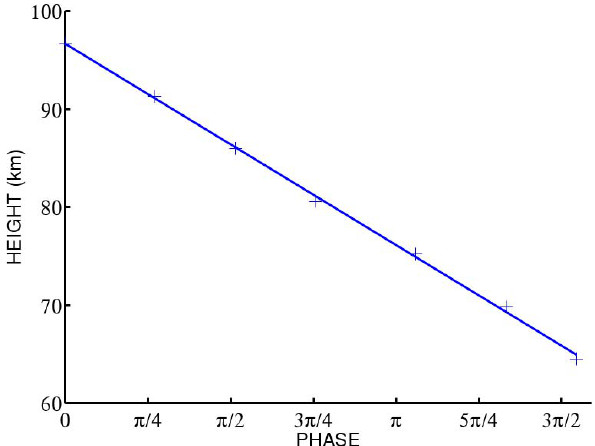
Fig. 13. Aura MLS E1 UFKW monthly-mean amplitudes averaged over the 2.5–4.5 day period band as a function of height for a com- posite year of the 2005–2010